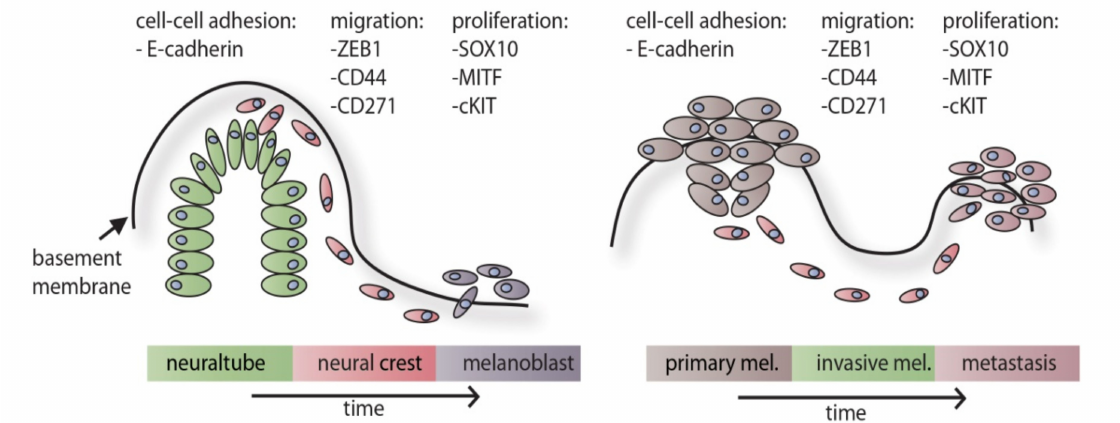
Figure 1. Comparison of embryonic melanocyte generation and the metastatic process in malignant melanoma. Left panel depicts neural tube formation and subsequent delamination. Migration of neural crest cells is indicated following terminal di ff erentiation after invasion into the epidermis. Right panel depicts primary melanoma growth and subsequent migration and invasion of cells until melanoma cells colonize distant metastatic